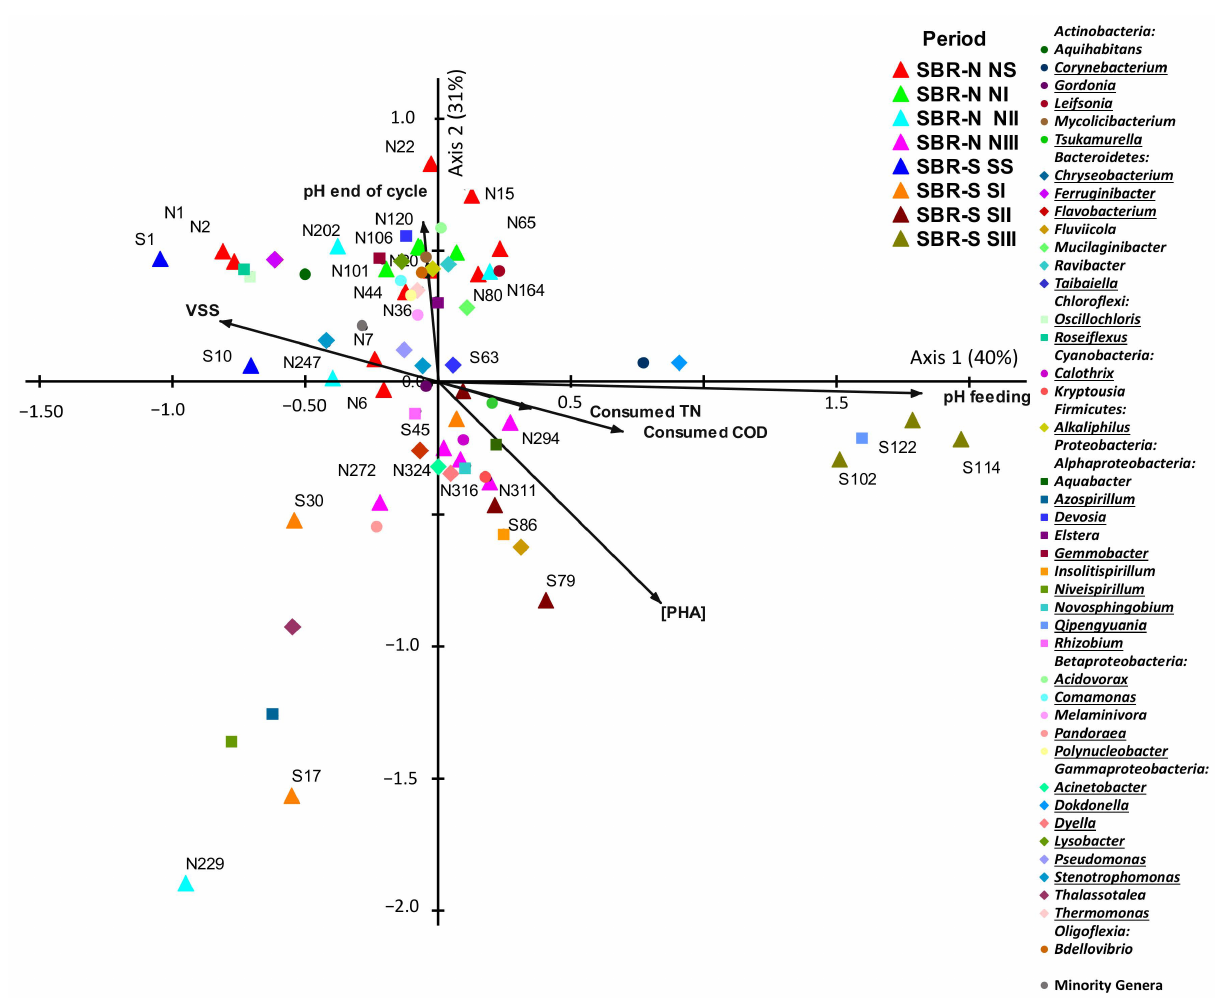
Figure 8. Nonmetric multidimensional scaling (NMS) ordination of dominant bacterial genera (RA < 0.5%) found in biomass samples retrieved from two SBRs operated under non-saline (SBR-N, 0.5 g NaCl/L) and saline (SBR-S, 10 g NaCl/L) conditions, and their links with the operational variables and PHAs accumulation yields. [PHA] (PHAs accumulation yield), pH feeding (pH of the feeding stream), Consumed COD (Total COD consumed), Consumed TN (Total N consumed), VSS (volatile suspended solids concentration in the reaction medium), pH end of cycle (pH at the end of the cycle). Genera potentially able to accumulate PHAs or described abundant in other PHA-accumulating SBRs are